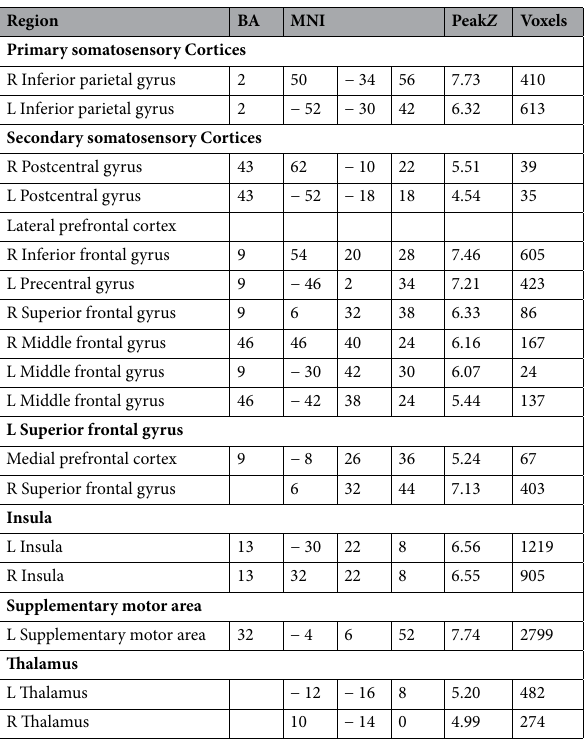
Table 1. MNI coordinates of the activated clusters in trial 1. In this trial, a stimulation current amplitude that was 1.5 times that of the standard amplitude was applied. Threshold values of uncorrected p and cluster extent k were set as smaller than 0.001 and more than 20, respectively. L left hemisphere; R right hemisphere.